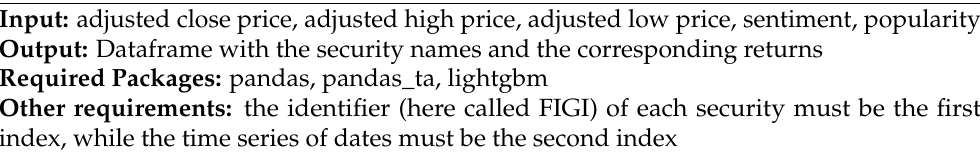
Algorithm A2 Trend indicator for multiple securities into a MultiIndex